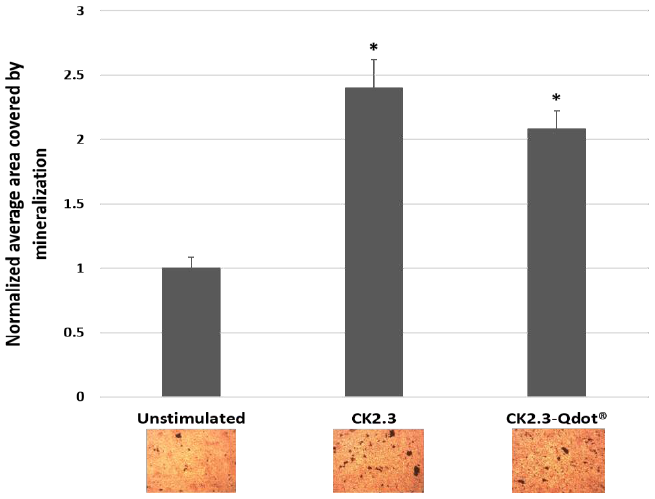
Figure 5. Mineralization levels in unstimulated C2C12 cells and cells treated with 100 nM of CK2.3 and CK2.3-Qdot®s was determined using von Kossa assay. Data was analyzed using one-way anova and Tukey-Kramer post hoc statistical test. * denotes statistical significance at p-value of 0.05 compared to unstimulated cells. CK2.3 and CK2.3-Qdot®s induced 2.4 ± 0.221 and 2.07 ± 143 fold more mineralization compared to unstimulated cells; respectively.